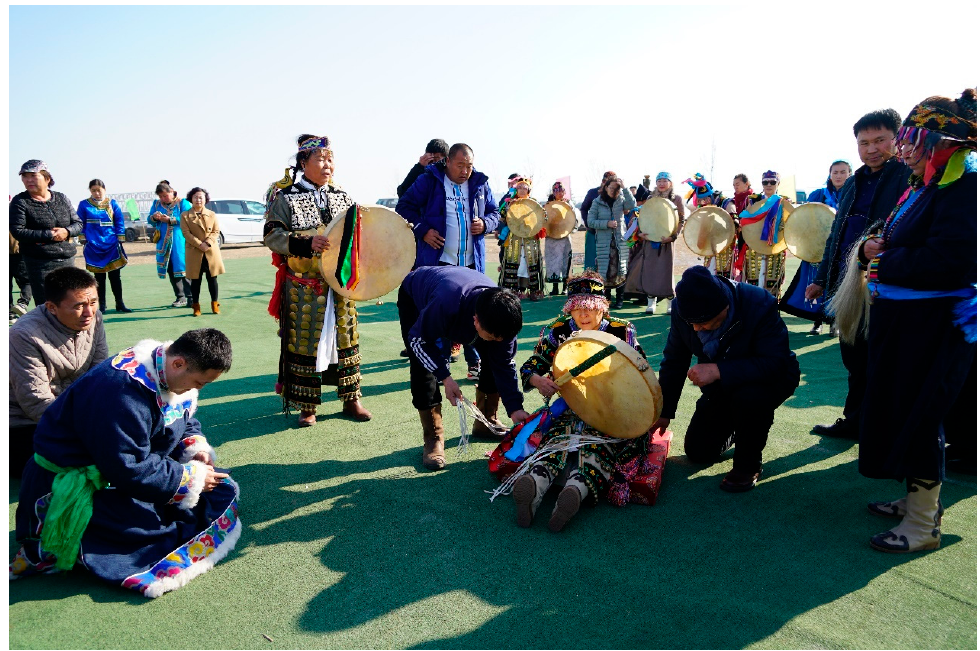
Figure A10. The new shaman ancestral spirit ʊ ŋ ɡ ʊ r is invoked (On 24 October 2017, Meng Yujin’s initiation ritual as jad’ ə n ). Photo: Minna Sa, 2017.